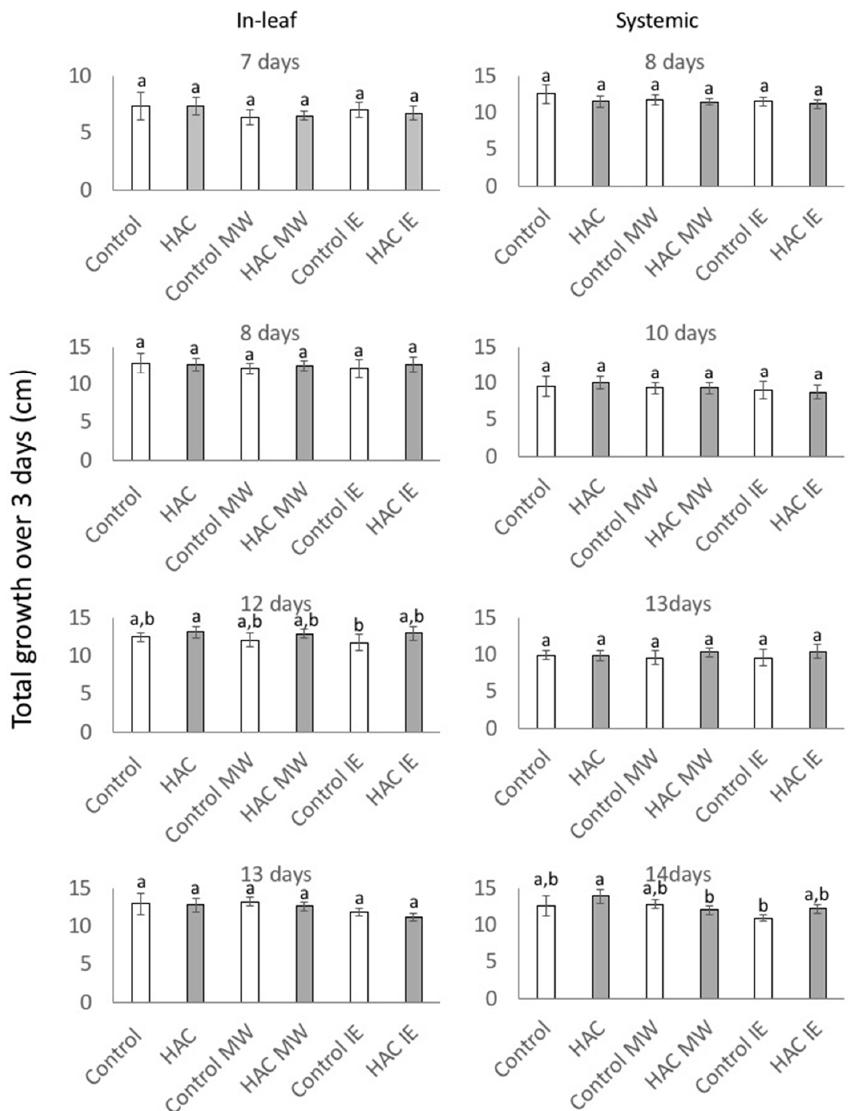
Figure 5. The growth response of ( Z )-3-hexen-1-yl acetate (Z-3-HAC)-treated and untreated maize ( Zea mays ) seedlings ( n ≥ 7) after MW and IE treatment over 3 days. Seedlings were first exposed to physiological concentrations of Z-3-HAC (2 µ g L − 1 air volume) for 16 h and then treated with MW or IE as described above. Total growth (in cm) is shown. Values are means ± SE and different letters indicate significant differences between treated and untreated seedlings ( ANOVA , P <